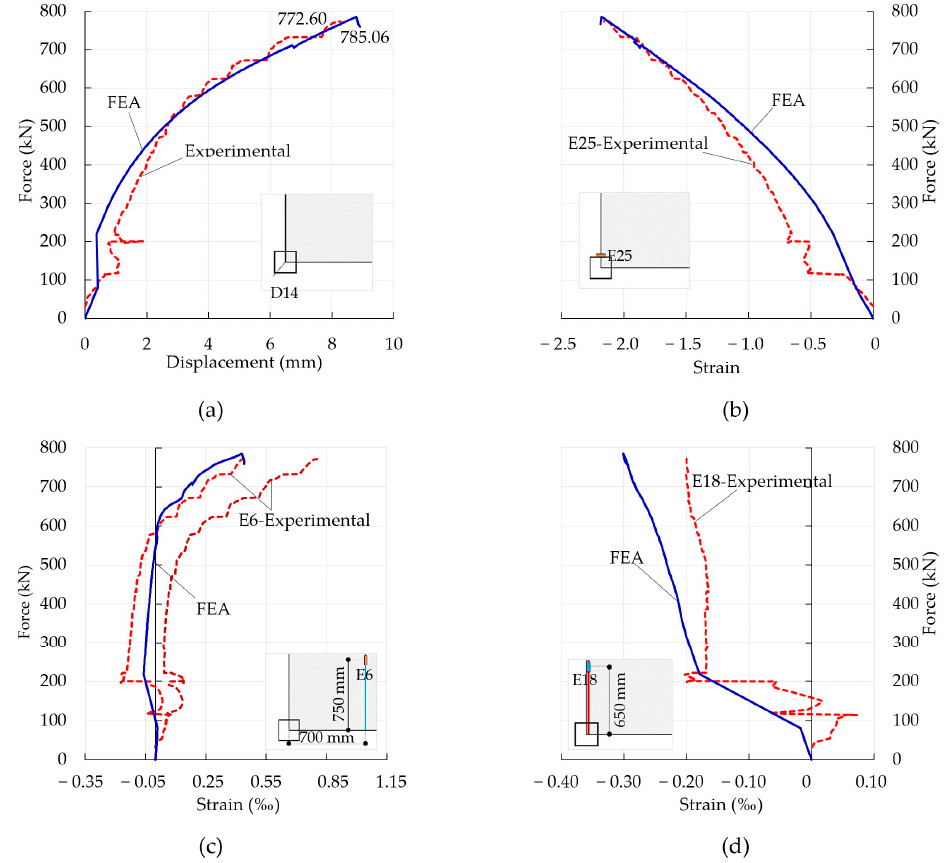
Figure 10. Comparison of numerical and experimental results of the M4 model.